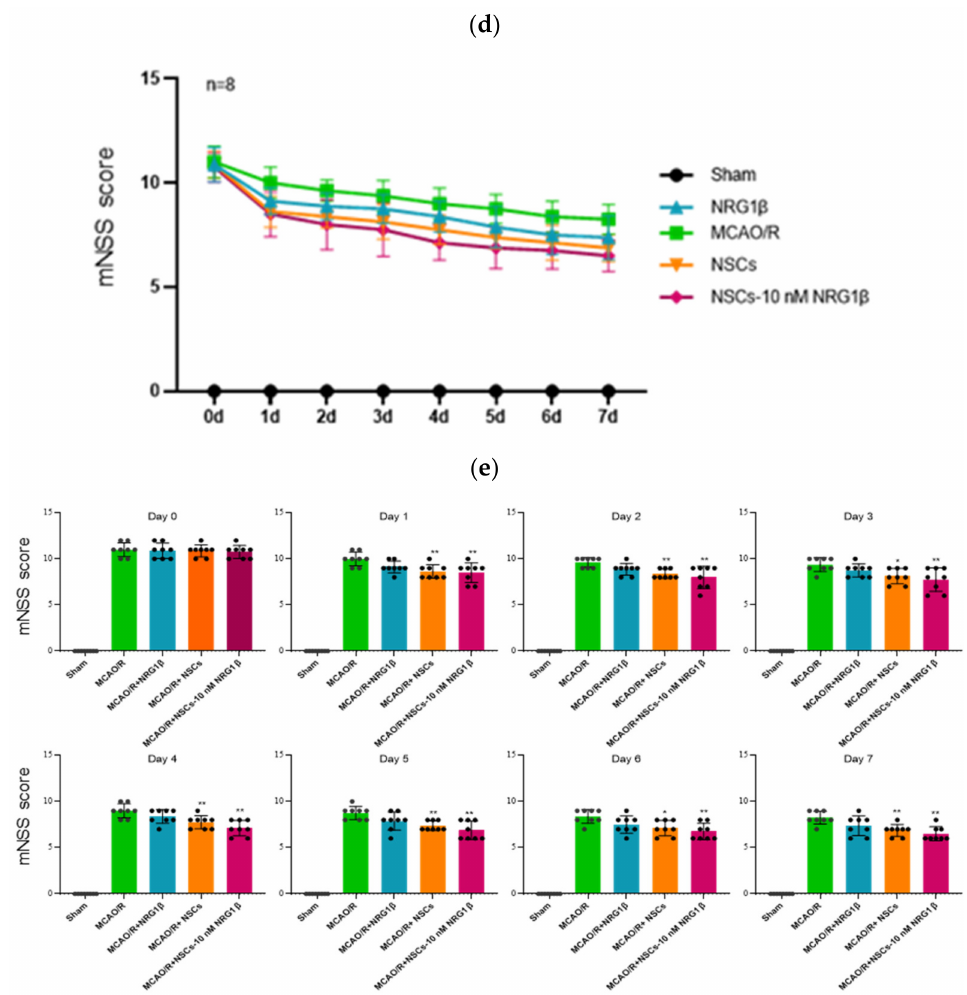
Figure 1. Effects of NSCs transplantation on neurobehavioral score in MCAO/R rats. ( a ) Morphologi- cal images of NSCs and NSCs-10 nM NRG1 β induced at day 3 and 7 in vitro; ( b ) NSCs is positive for SOX2 (green) and Nestin (red). ( c ) The fluorescence intensity analysis of SOX2 and Nestin in control and 10 nM NRG1 β group. ( d , e ) Behavioral tests after surgery or transplantation in rats from 0–7 days in MCAO/R, MCAO/R + NRG1 β , MCAO/R + NSCs and MCAO/R + NSCs-10 nM NRG1 β . Data are expressed as mean ± SD. * p < 0.05, ** p <